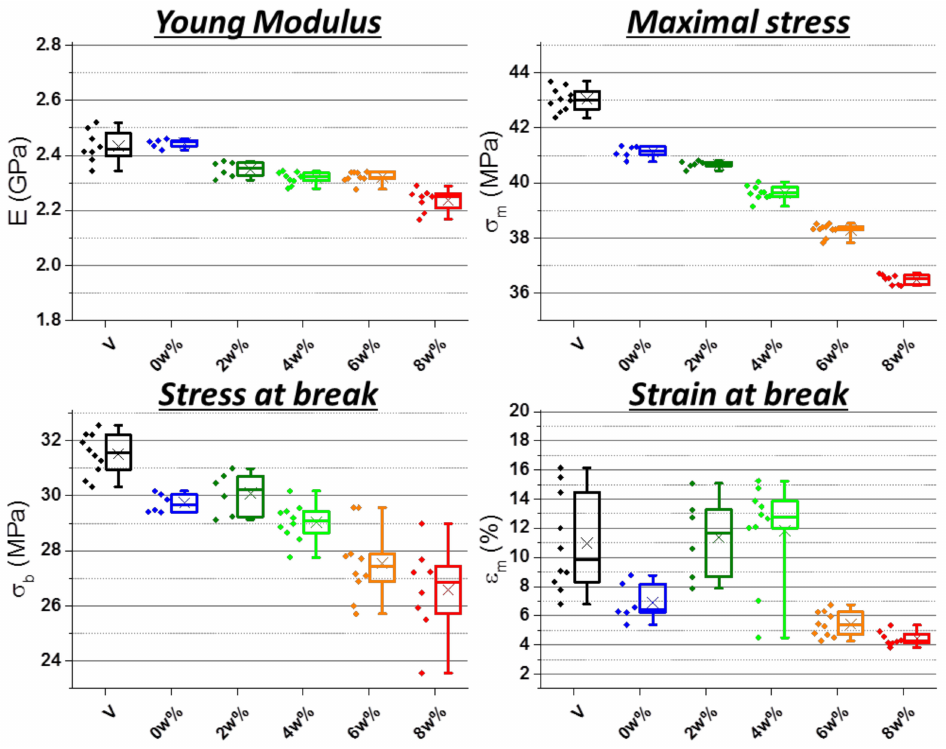
Figure 5. Young Modulus, maximal stress, stress and strain at break from tensile tests on ABS contaminated at increasing rates of PP—“V” for directly injected ABS, “0 wt%” went through